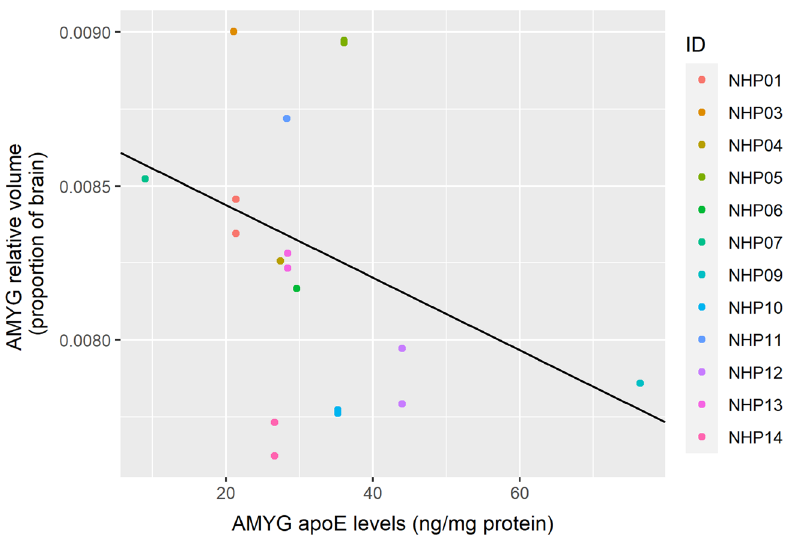
Figure 4. Levels of apoE in the AMYG negatively predicts relative AMYG volume. The figure shows results from a GEE model using AMYG apoE levels as the sole predictor. Individual macaque IDs are distinctly